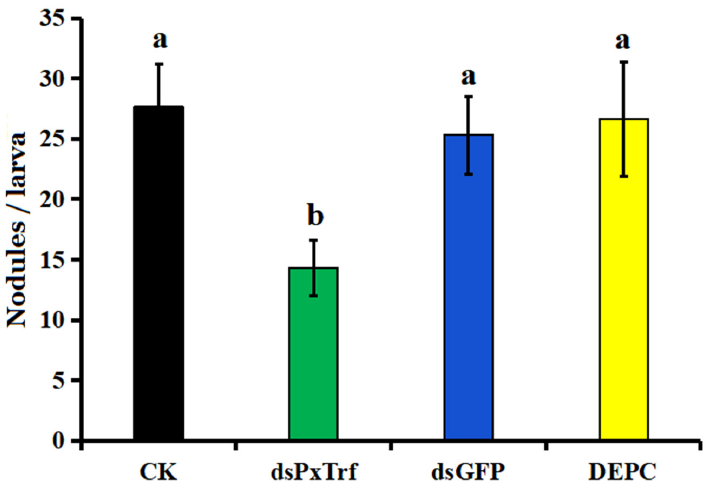
Figure 6. Infuence of dsPxTrf treatment on hemocyte nodulation. CK: without dsRNA injection. dsPxTrf: dsPxTrf injection. dsGFP: dsGFP injection. DEPC: DEPC-treated water injection. Data are